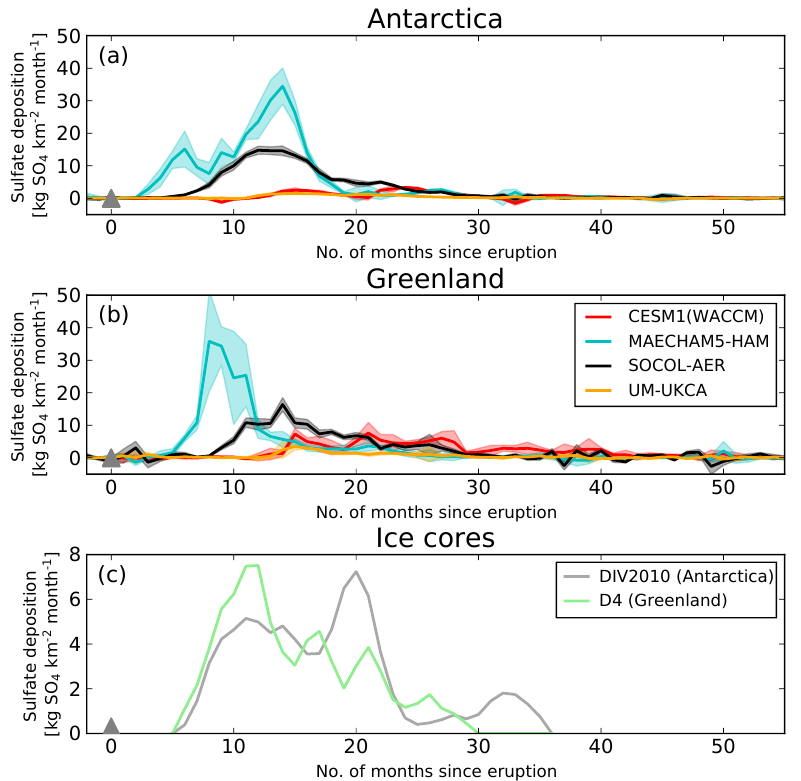
Figure 9. Simulated area-mean volcanic sulfate deposition (kgSO 4 km − 2 month − 1 ) to the Antarctic ice sheet (a) and Greenland ice sheet (b) for each model (colours). Each ice sheet mean is defined by taking an area-weighted mean of the grid boxes in the appropriate regions once a land–sea mask has been applied. Solid lines mark the ensemble mean and shading is 1 SD. (c) Deposition fluxes from two monthly-resolved ice cores (DIV2010 from Antarctica and D4 from Greenland). The scale is reduced in (c) . The grey triangles mark the start of the eruption (1 April 1815).